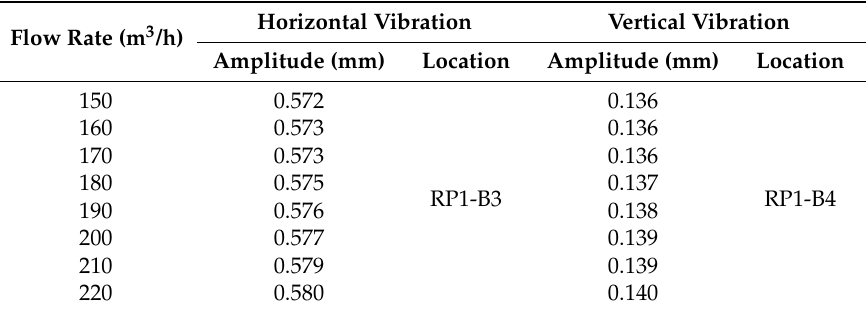
Table 9. The maximum amplitudes of RP1 outlet pipe at different flow